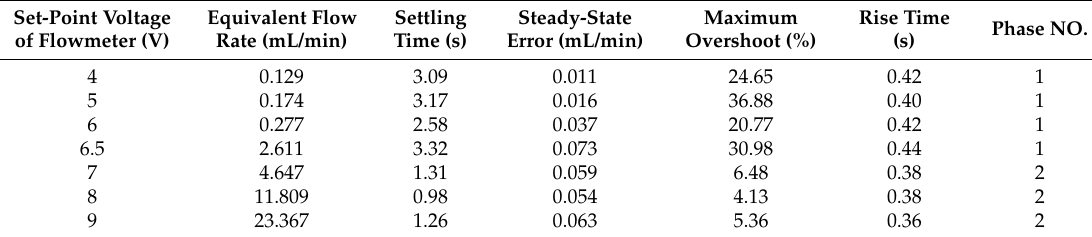
Table 1. Indexes of the transient responses.